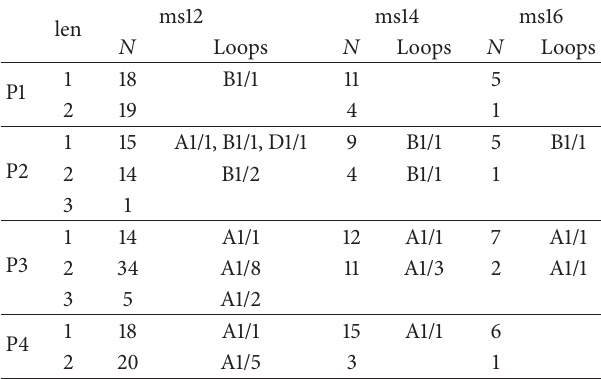
Table 3: Number of patterns ( 𝑁 ) by length (len) by